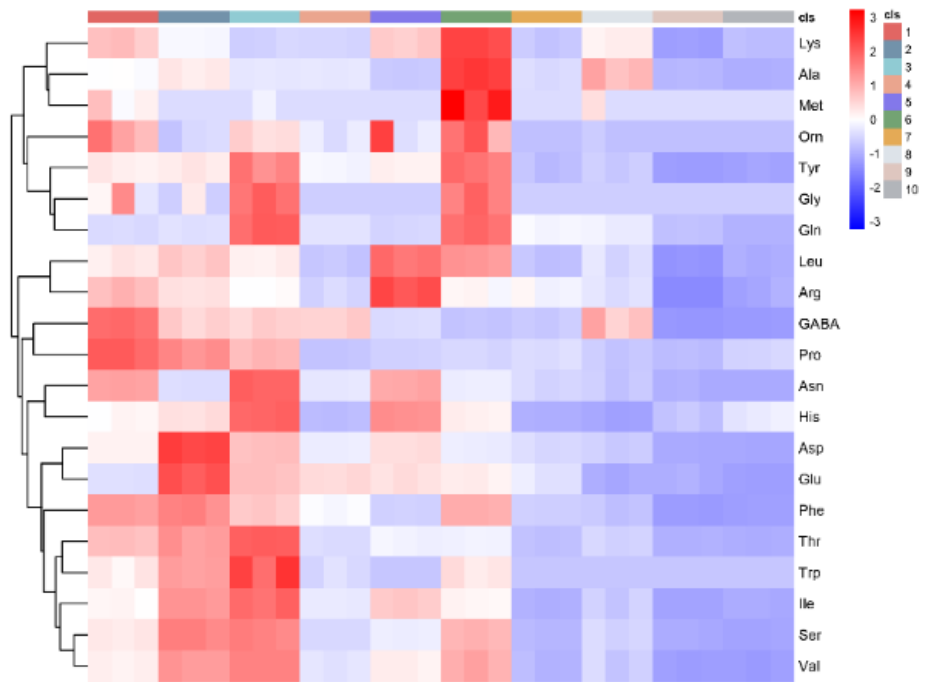
Figure 2. Heat-map of amino acid concentration values in 10 peach and nectarine varieties. 1 indicates Jinxia; 2 indicates Yuhua3; 3 indicates Tropic Prince; 4 indicates Dahezaosheng; 5 indicates Yixianhong; 6 indicates Chengxiang; 7 indicates NJN76; 8 indicates Sazizaosheng; 9 indicates Hongrou1; 10 indicates Touxinhong.